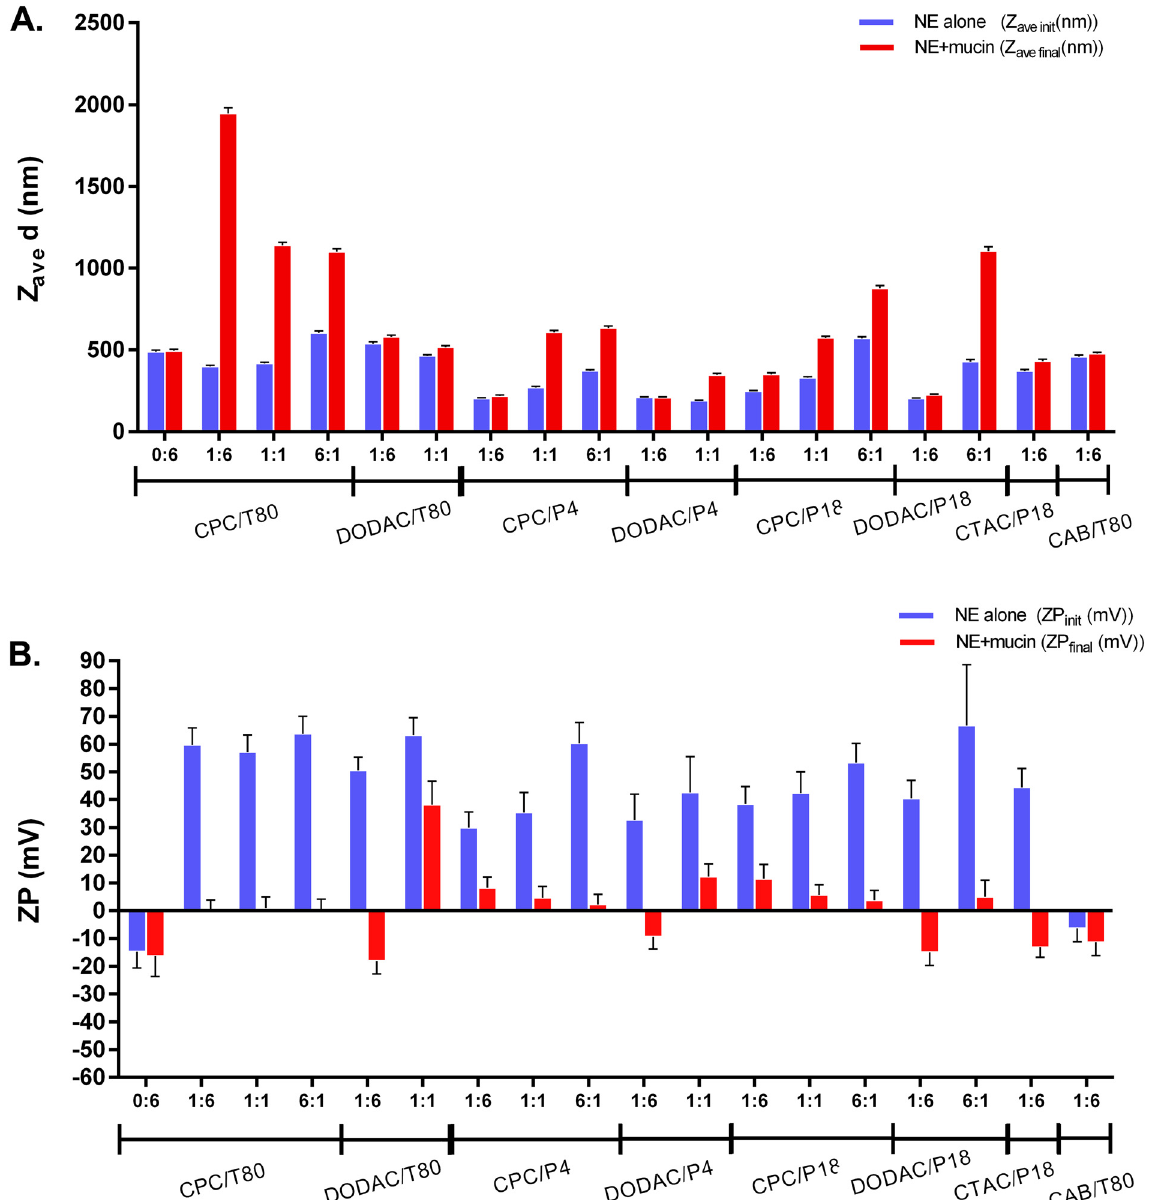
Fig 2. Mucoadhesion of NE. (A) Particle size (Zave d) and (B) ZP of 0.1% NE incubated with and without 0.05 mg/mL